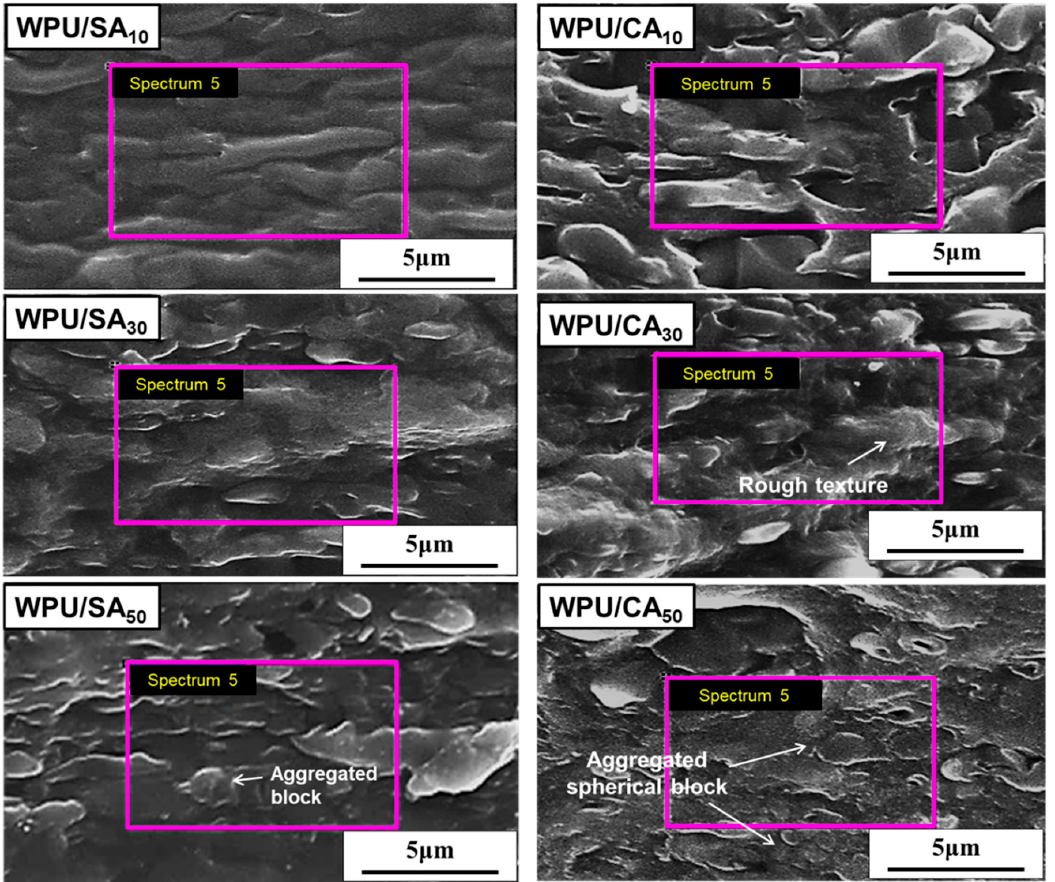
Figure 6. SEM morphology of the cross-sections of the WPU/SA blends and WPU/CA